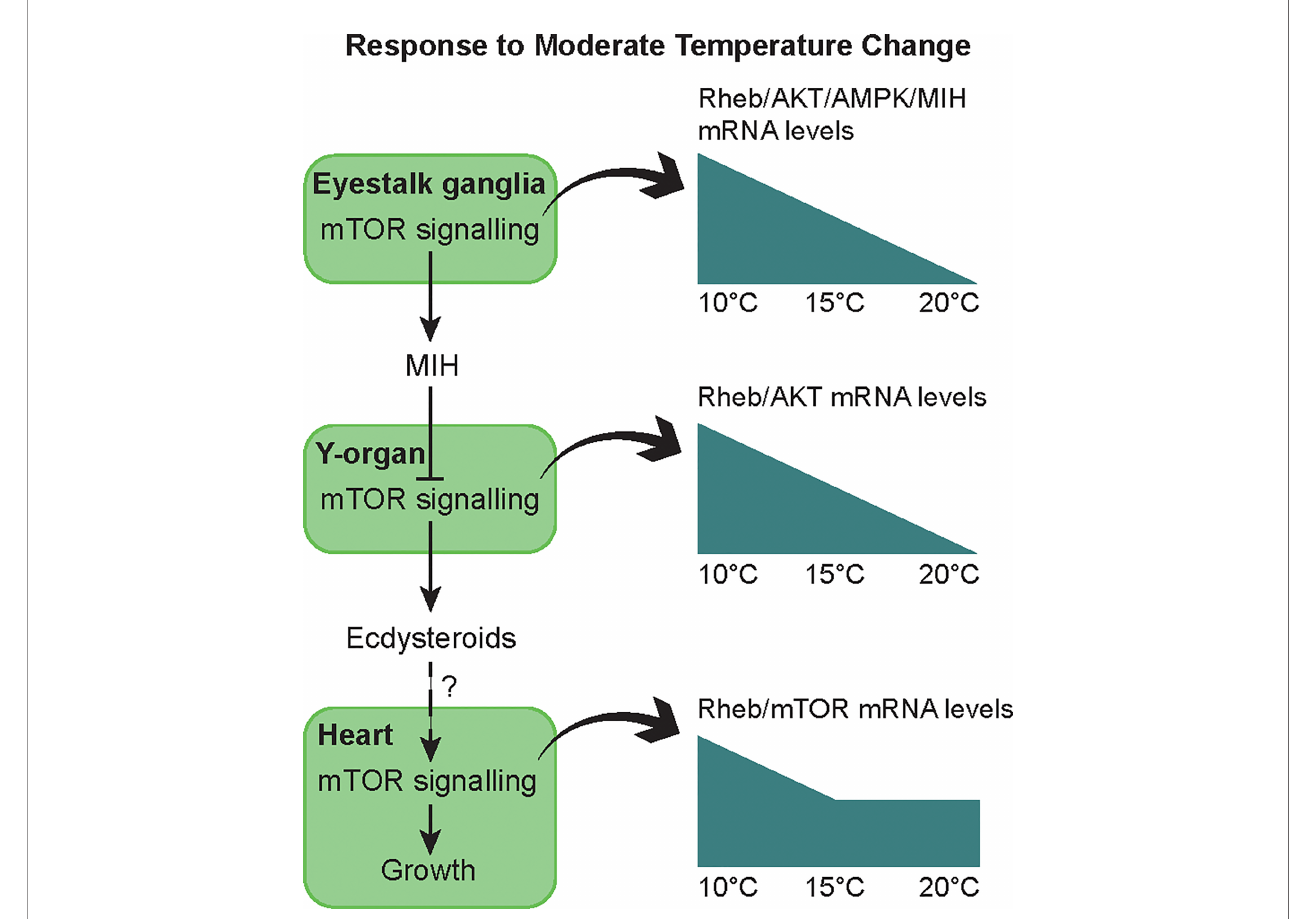
FIGURE 6 | Summary of the effects of moderate thermal stress on molting and growth through the mTOR signaling pathway in juvenile Dungeness crabs. In intermolt, MIH keeps the YO in a basal state with low ecdysteroid secretion by inhibiting mTOR. Low levels of ecdysteroid may stimulate heart muscle growth via mTOR signaling. Moderate temperature change (10 to 20°C range) allows acclimation of the animals, at least with respect to some physiological functions. After 14 days, thermal compensation is observed in molt control, i.e. similar ecdysteroid titer across temperatures throughout the molt cycle (187). Mechanisms include up-regulation or down-regulation of Mm-MIH and mTOR signaling genes ( Mm-Rheb , Mm-Akt , Mm-AMPK ) during cold (10°C) or warm (20°C) exposure in the eyestalk ganglia and YO. In the heart, thermal compensation of metabolism is incomplete, as oxygen demand and heart activity increase with temperature. A sustained mRNA level of Mm-Rheb and Mm-mTOR indicates a greater allocation of energy to maintaining cardiac capacity during warm exposure. From